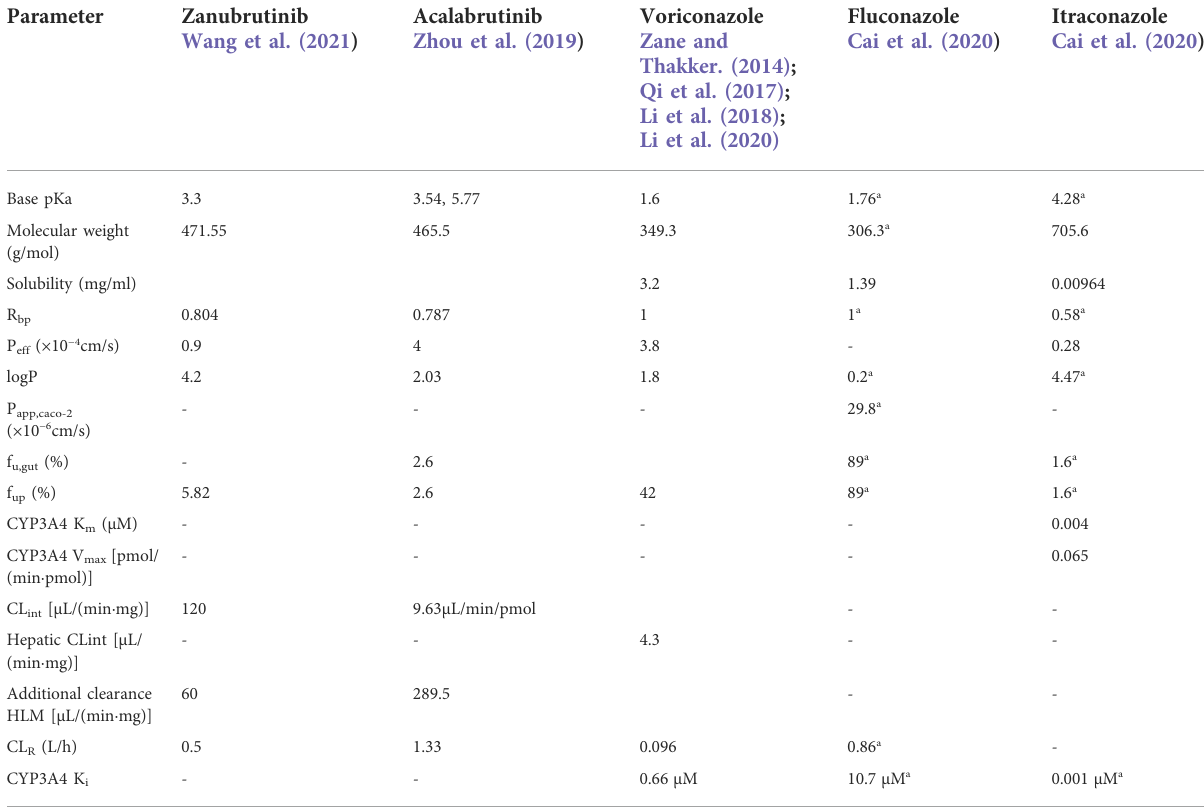
TABLE 1 Physicochemical property values used for PBPK modeling of zanubrutinib, acalabrutinib, voriconazole, fl uconazole and itraconazole.